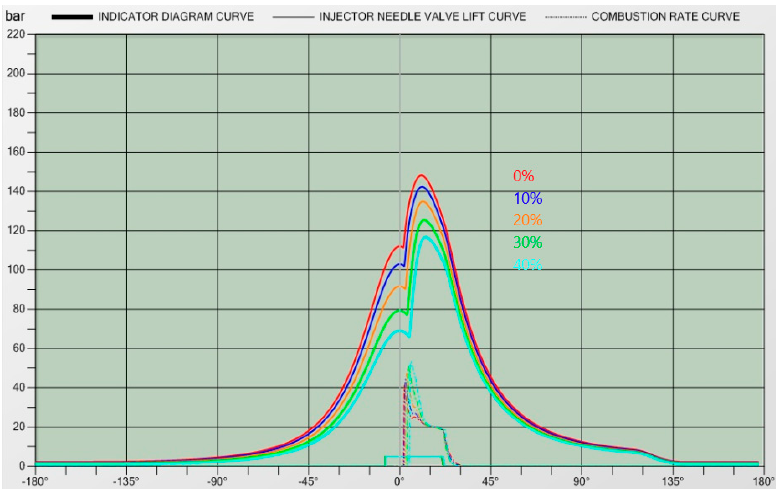
Figure 5. Indicator diagram for turbine blade faults.